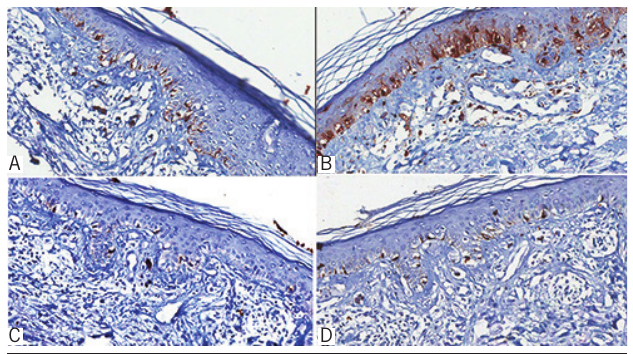
figurE 2 − Case 1: A) numerous isolated cells in the basal layer, in a continuous pattern, labeled with Melan-A, mimicking melanoma in situ ; B) S100 stain highlighted junctional melanocytes as well as langerhans cells in the epidermis; C and D) a normal number of melanocytes labeled with HMB45 (C) and tyrosinase (D) HMB45: human melanoma black 45.